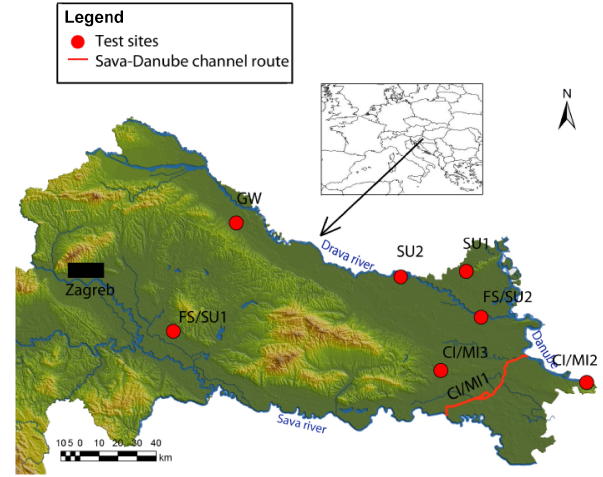
Figure 1. Map of northern Croatia with test site